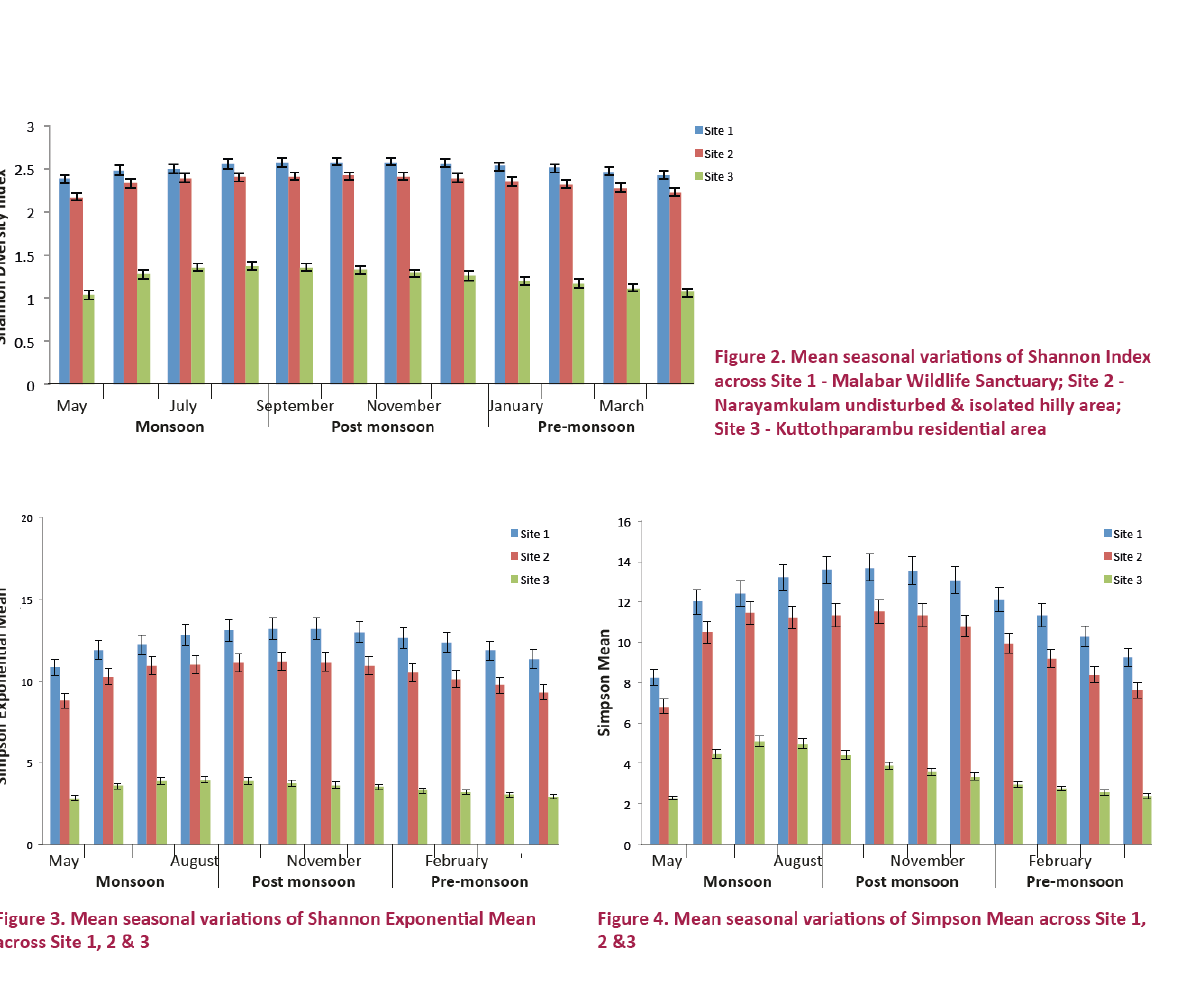
Ffigure 4. Mean seasonal varfiafions of Sfimpson Mean across Sfite 1, 2 &3